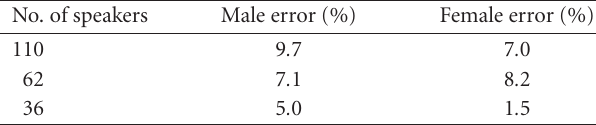
Table 2: Misclassification errors for male and female